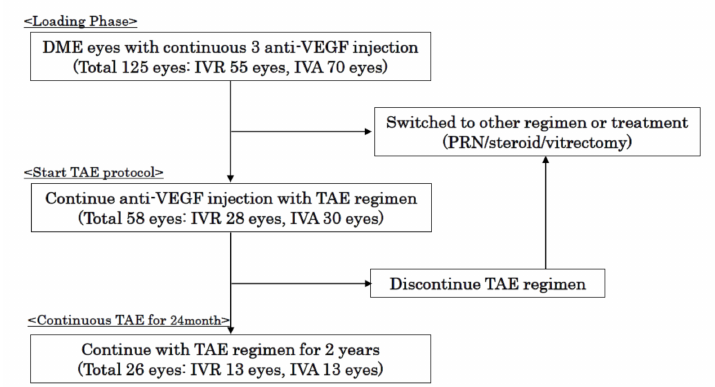
Figure 1. Flowchart of the study. A total of 125 eyes from 125 patients (55 patients received intravitreal ranibizumab (IVR) and 70 patients received intravitreal aflibercept (IVA)), diagnosed as treatment-naïve diabetic macular edema (DME), who had received 3-consecutive monthly IVR or IVA injections